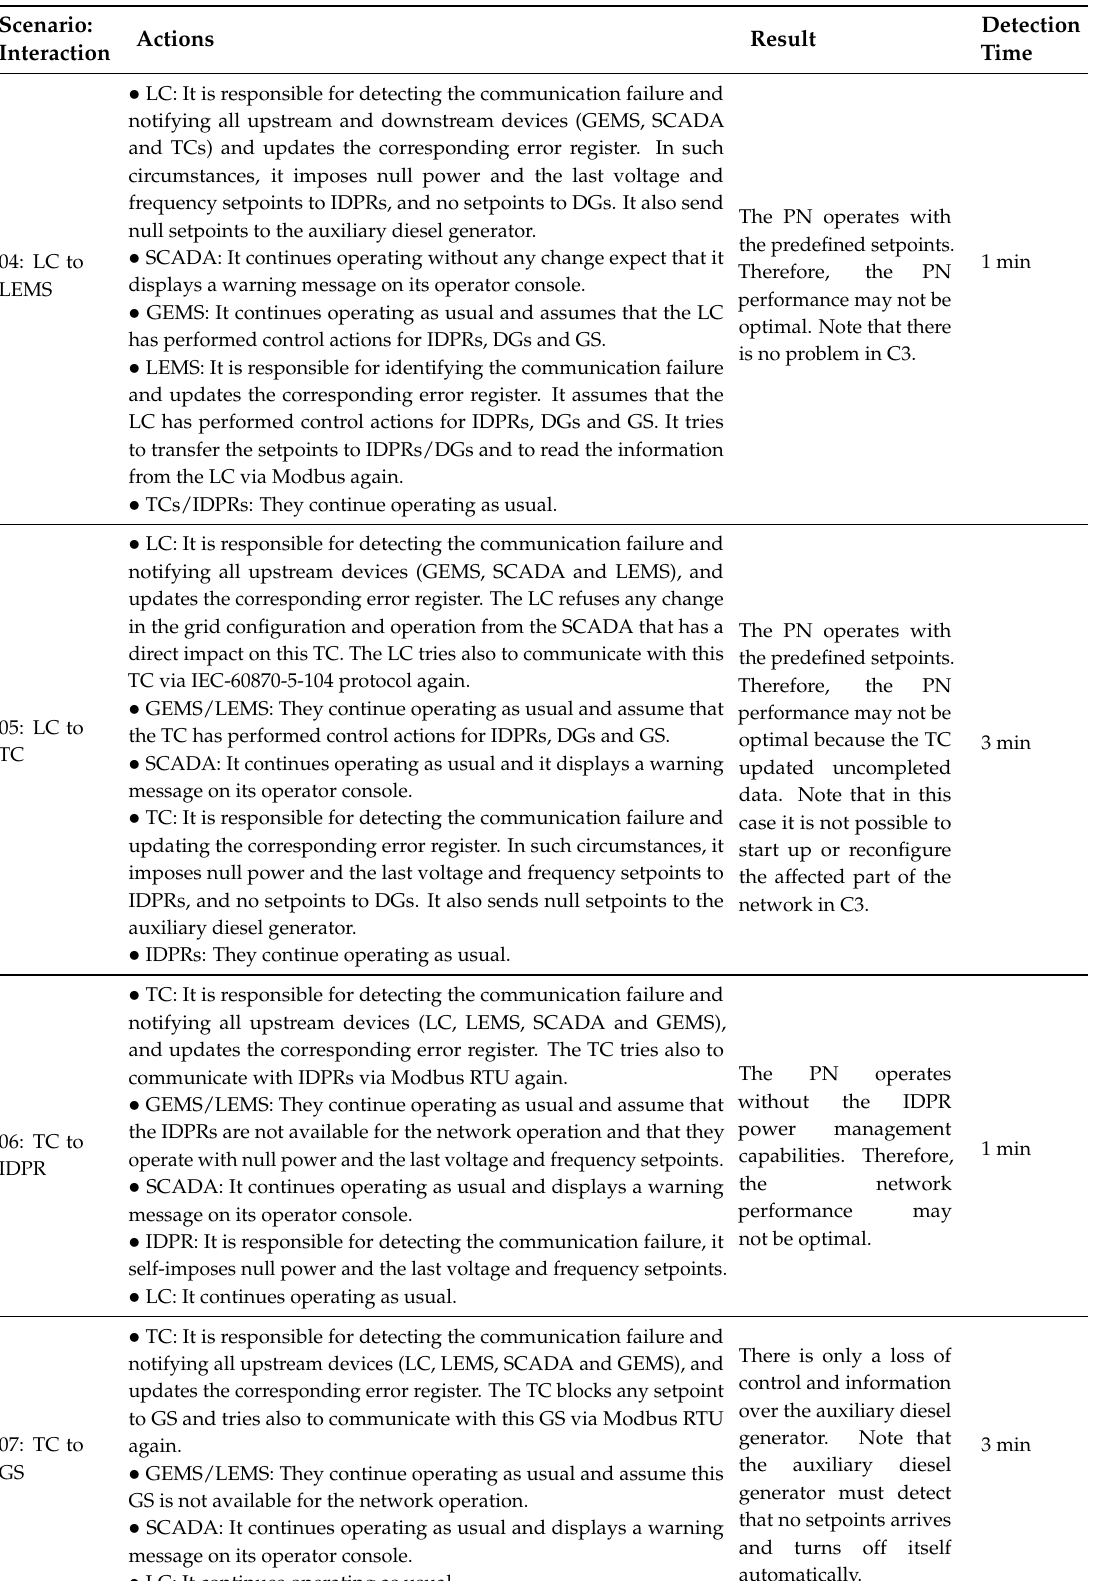
Table 6. Actions in functions of the operational circumstances 1, 2, and 3. Part